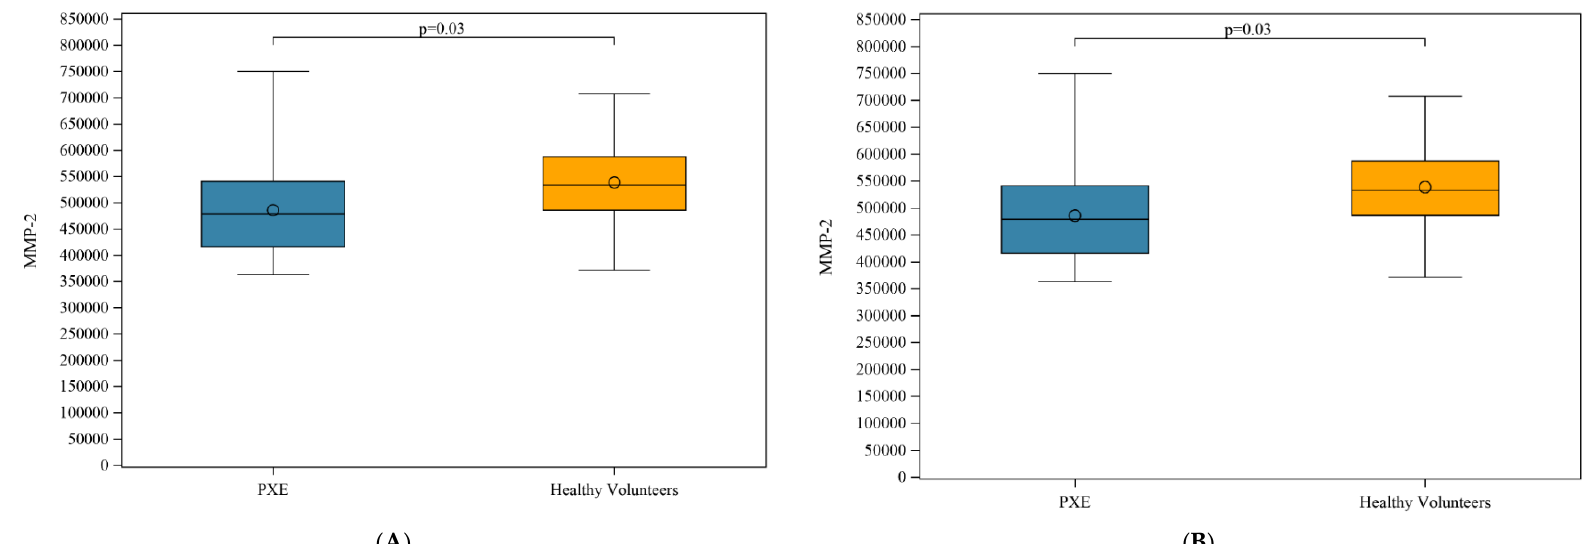
Figure 6. ( A ) Plasma levels of MMP-2 in PXE patients and healthy volunteers; ( B ) MMP-3 in PXE patients and healthy volunteers. Table 4. Chemokines, cytokines, growth factors, lectin adhesion molecules, osteogenic factors, matrix metalloproteinase and fibrogenic factors in plasma samples from PXE patients and Healthy Volunteers.